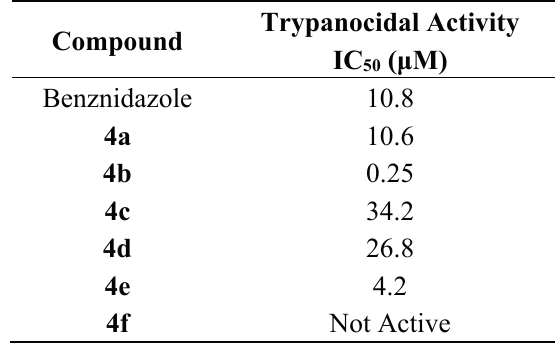
Table 1. Trypanocidal activity of diazepines 4a – f against the epimastigotes forms of Y-strain T. cruzi